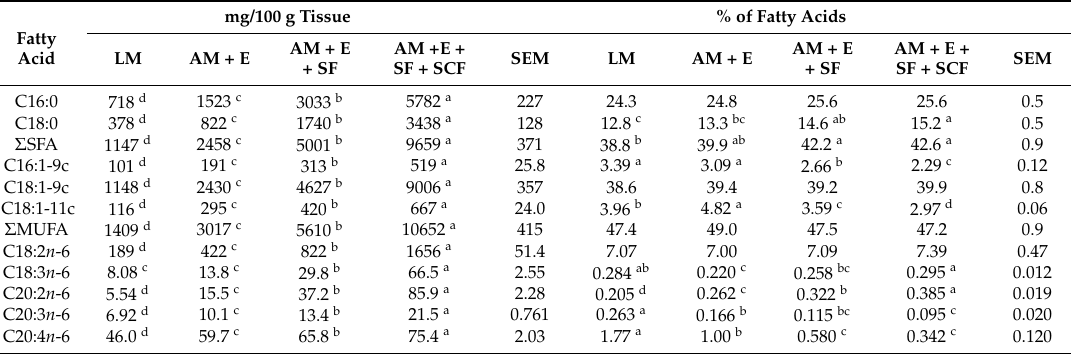
Table 1. Typical fatty acid composition of longissimus muscle and associated tissues in pork from pigs fed a barley/wheat/soybean meal